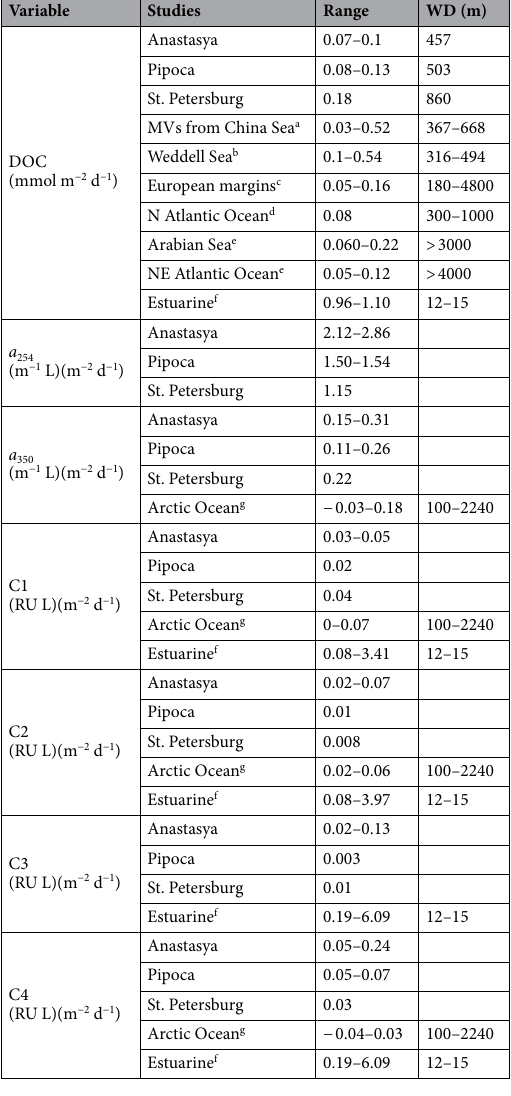
Table 2. Estimated diffusive benthic fluxes of DOC, CDOM, and FDOM in the three MVs. Fluxes from other regions are also displayed (WD: water column depth). a Hung et al. 19 ; b Hulth et al. 58 ; c Otto and Balzer 59 ; d Alperin et al. 60 ; e Lhajnar et al. 61 ; f Burdige et al. 35 *; g Chen et al. 36 . Positive fluxes are out of the MVs. *1 RU = 64 μg